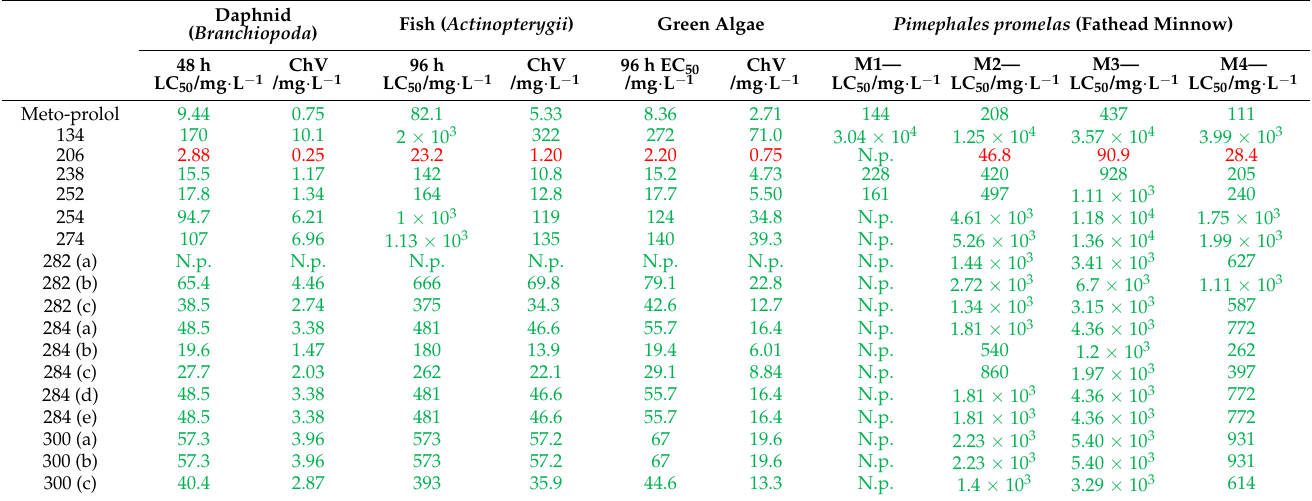
Table 4. QSAR analysis of metoprolol and with less (green) and more hazardous (red) degradation and transformation products from UV irradiation and ozonation using the OECD-QSAR toolbox. Daphnid ( Branchiopoda